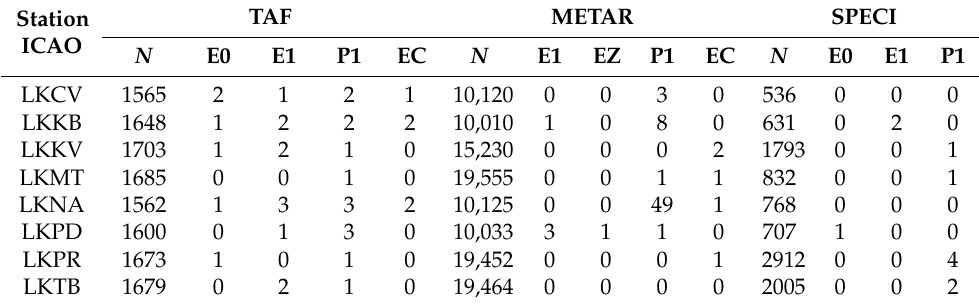
Table 5. Overview of the number of real processed reports and reports eliminated from